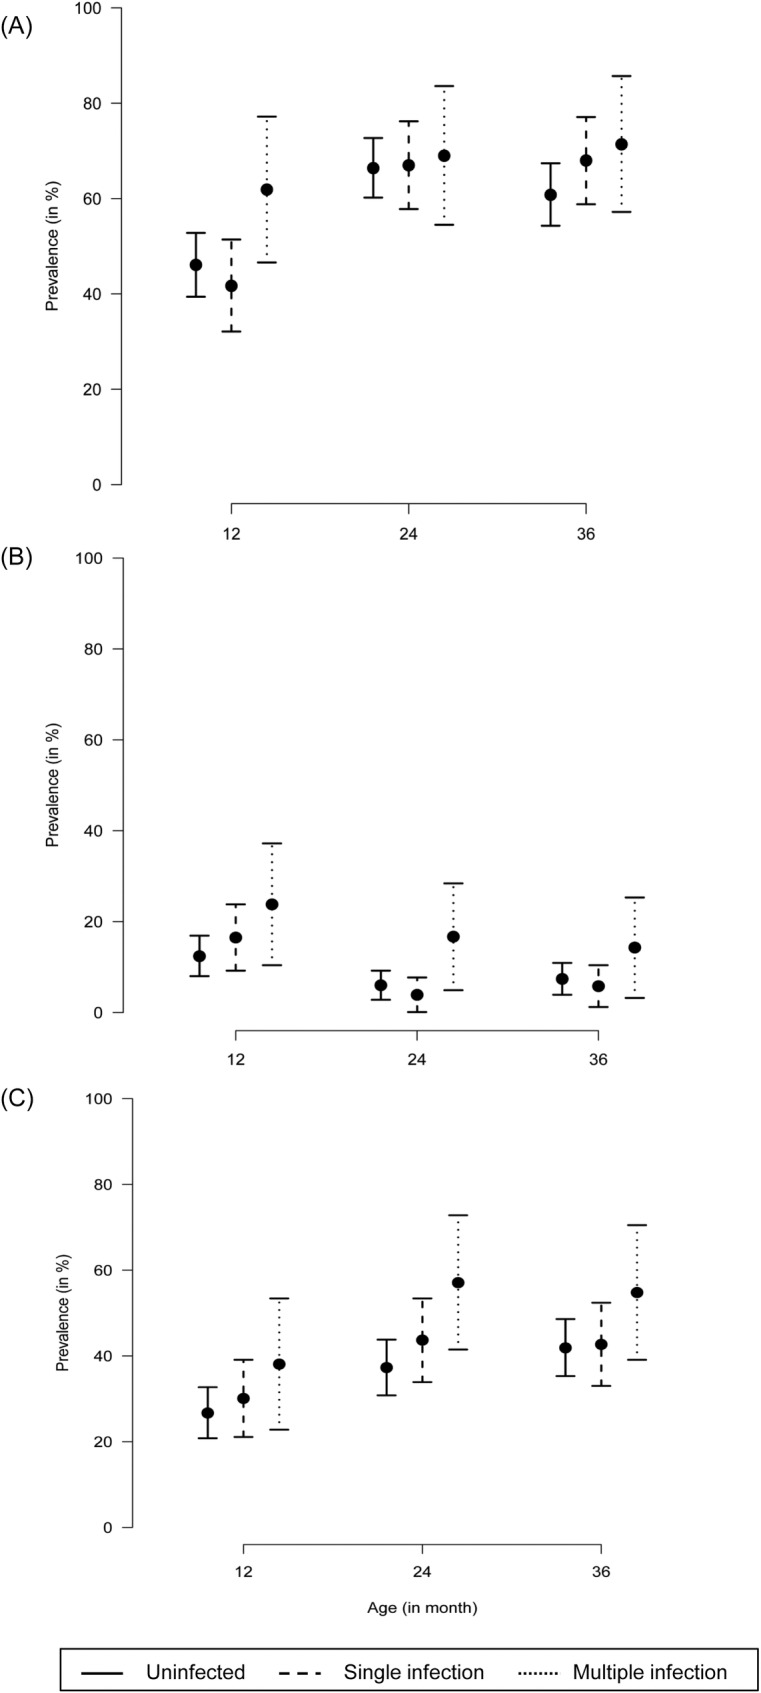
Proportion (with 95% CI) of (A) stunted, (B) wasted and (C) underweight children at 12, 24 and 36 months of age. The y-axis depicts the proportion of children with growth deficiency whereas the x-axis represents age in months. The point prevalence is presented as a circle and the 95% CI is represented as vertical lines. The solid vertical line represents uninfected children, the dashed and dotted lines represent those with single and multiple norovirus infections, respectively.